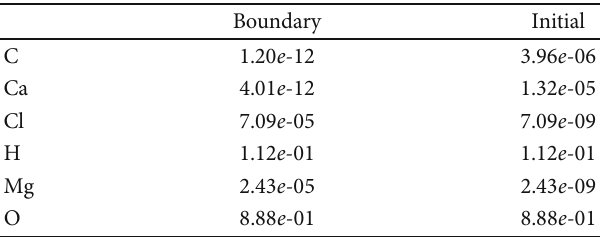
Figure 3: Distributions of (a) c and (b) ρ and T at t = 100 days. The solid and dotted curves show the numerical and analytical solutions, t respectively. Table 8: Fluid composition (mass fractions) at the in fl ow boundary X = 0 and at t = 0